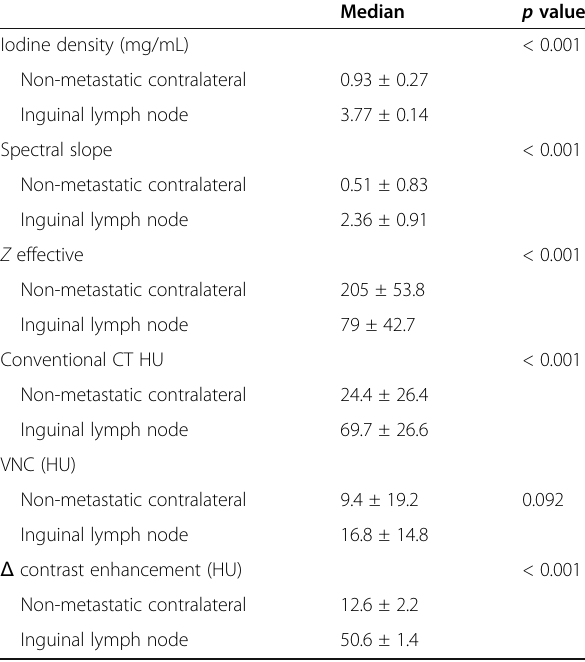
Table 3 Quantitative dual-layer spectral CT parameters from non-metastatic lymph nodes in arterial phase (contralateral axilla) and portal-venous phase (inguinal lymph nodes) Median p value < 0.001